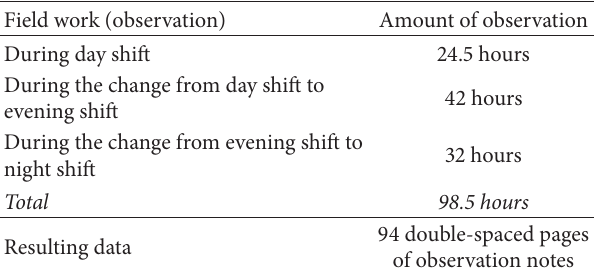
Table 1: Data collection